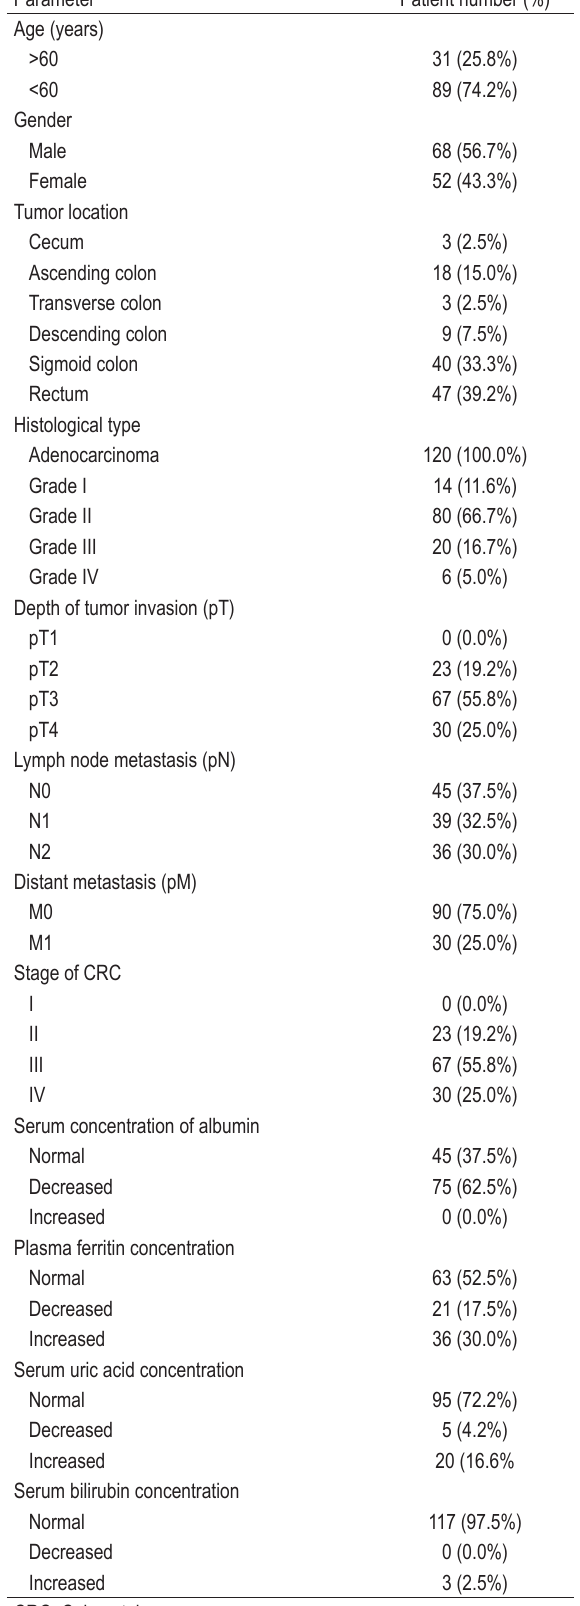
TABLE 1. Basic characteristics of the study group